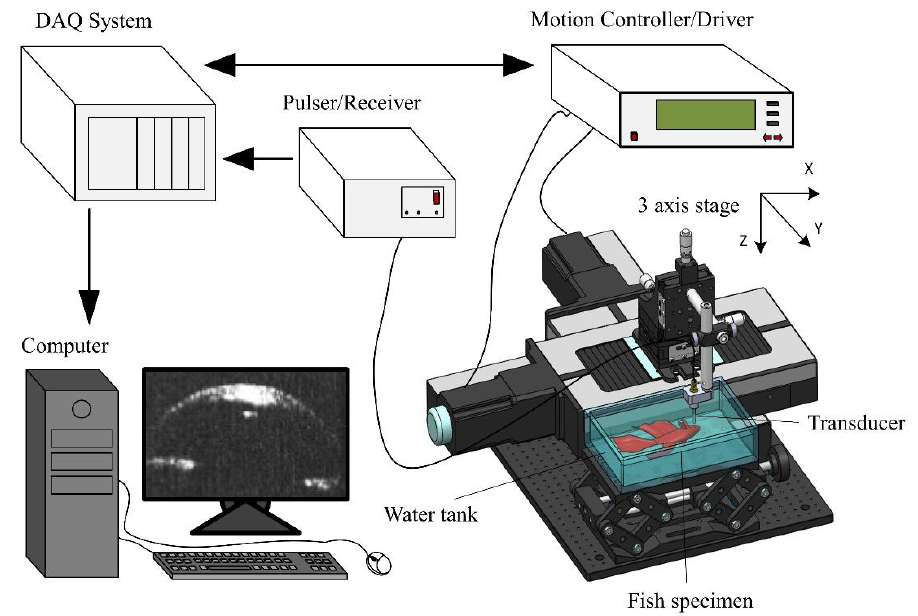
Figure 3. Schematic diagram of the experimental setup for ultrasound imaging using